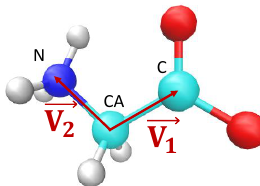
Figure 2. Glycine zwitterion. (cid:126) V 1 is a vector that connects the CA and C atoms within the molecule, and (cid:126) V 2 is a vector that connects the CA and N atoms within the